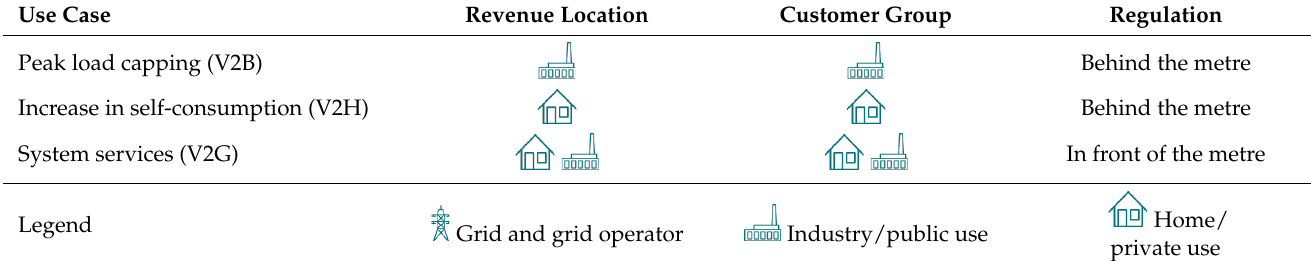
Table 1. Use cases of smart charging via price incentives ([7], Source: BDL project).